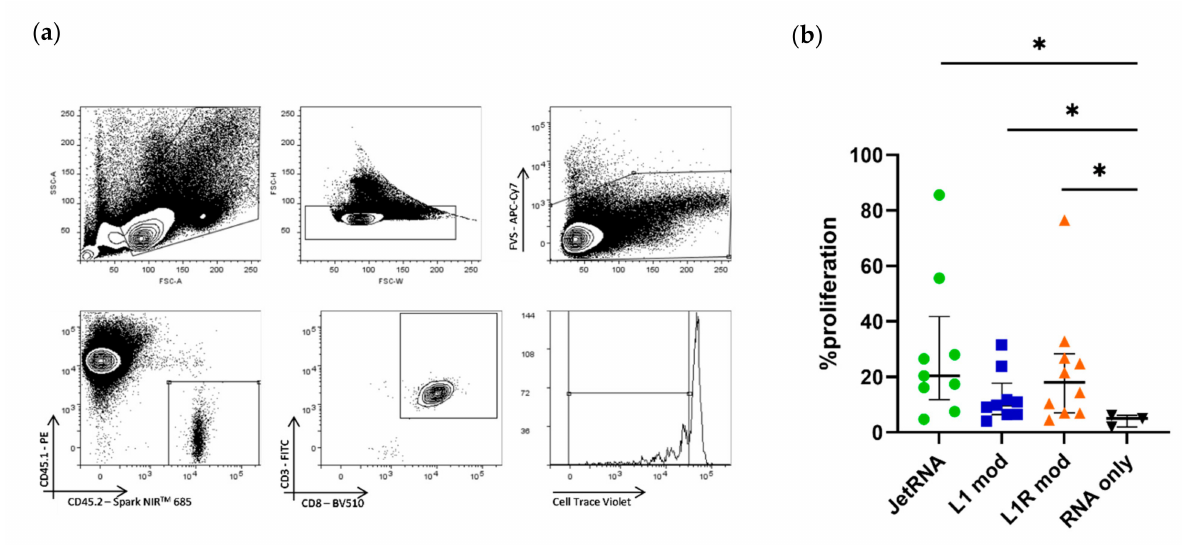
Figure 8. Immunization with histidine-rich peptide–mRNA formulations results in proliferation of CD8 + OT-I T cells. CD45.1 mice were injected with CTV-labelled CD45.2 + CD8 + OT-I splenocytes, and 2 days later they were immunized with 10 µ g of modified mRNA encoding tOVA complexed to either in vivo-jetRNA ® (JetRNA), LAH4-L1 (L1 mod), or LAH4-L1R (L1R mod). After 3 days, lymph nodes were harvested, and single-cell suspensions were analyzed by flow cytometry. Gating was performed on viable cells; subsequently, we looked for CTV dilution in the CD45.2 + CD3 + CD8 + T-cell population ( a ). Percentage of CD3 + CD8 + T-cell proliferation ( b ). Each symbol represents one mouse; median +/ − IQR. Mann–Whitney test: * p <